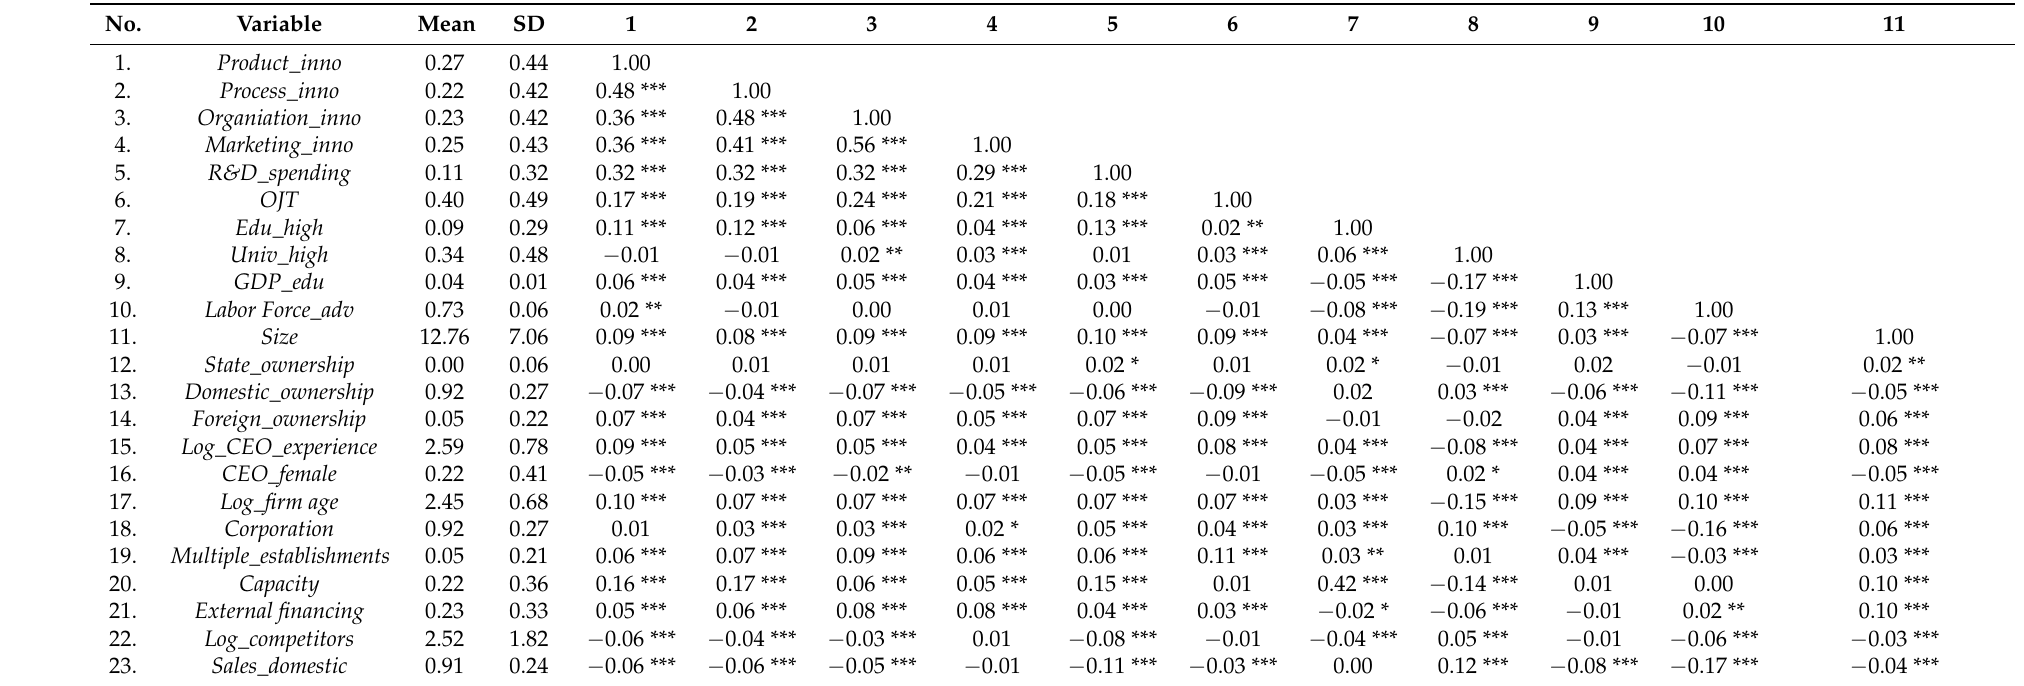
Table 4. Descriptive statistics (N =